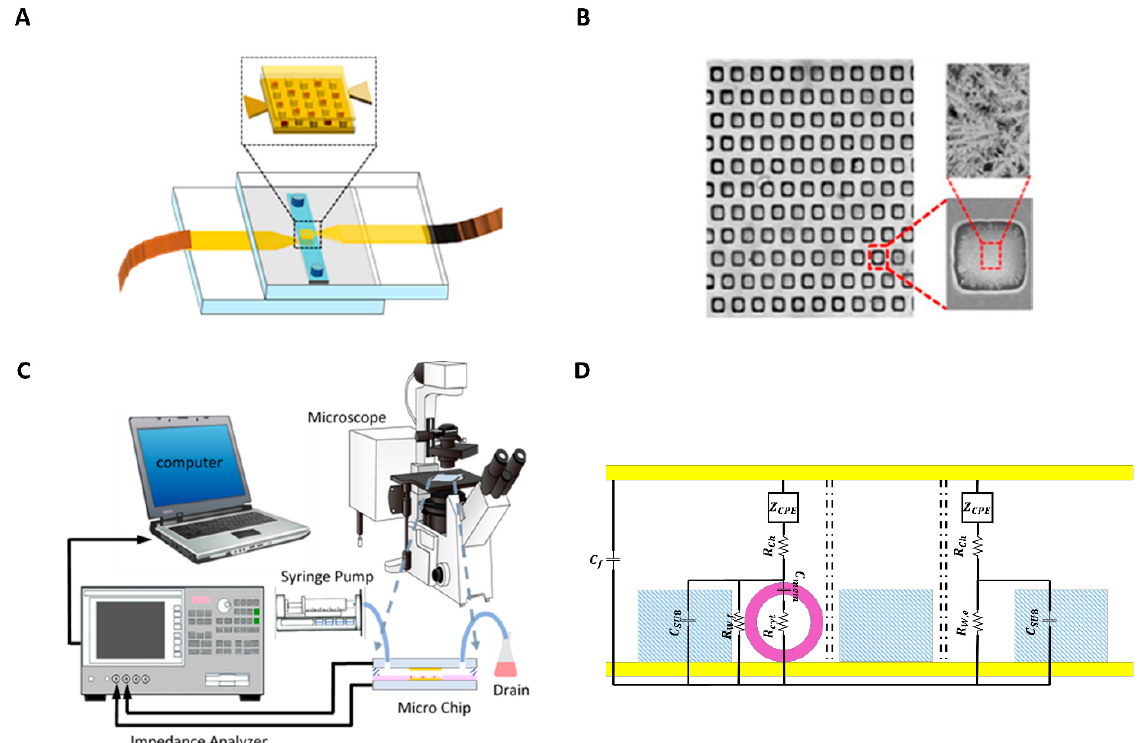
Figure 1. ( A ) Schematic of the microfluidic chip. ( B ) Picture of the microwells with nanostructured electrode surfaces. The figure shows the SEM images of the microwells array, zoomed view of a single microwell, and the dendritic structures on the electrodes on the bottom of the microwell. ( C ) Schematic view of the experimental setup. ( D ) Representation of the variables used in the equivalent circuit model of the device. The yellow part is the surface of the gold electrode. The purple is the membrane of the cell, and the blue part is the SU8.